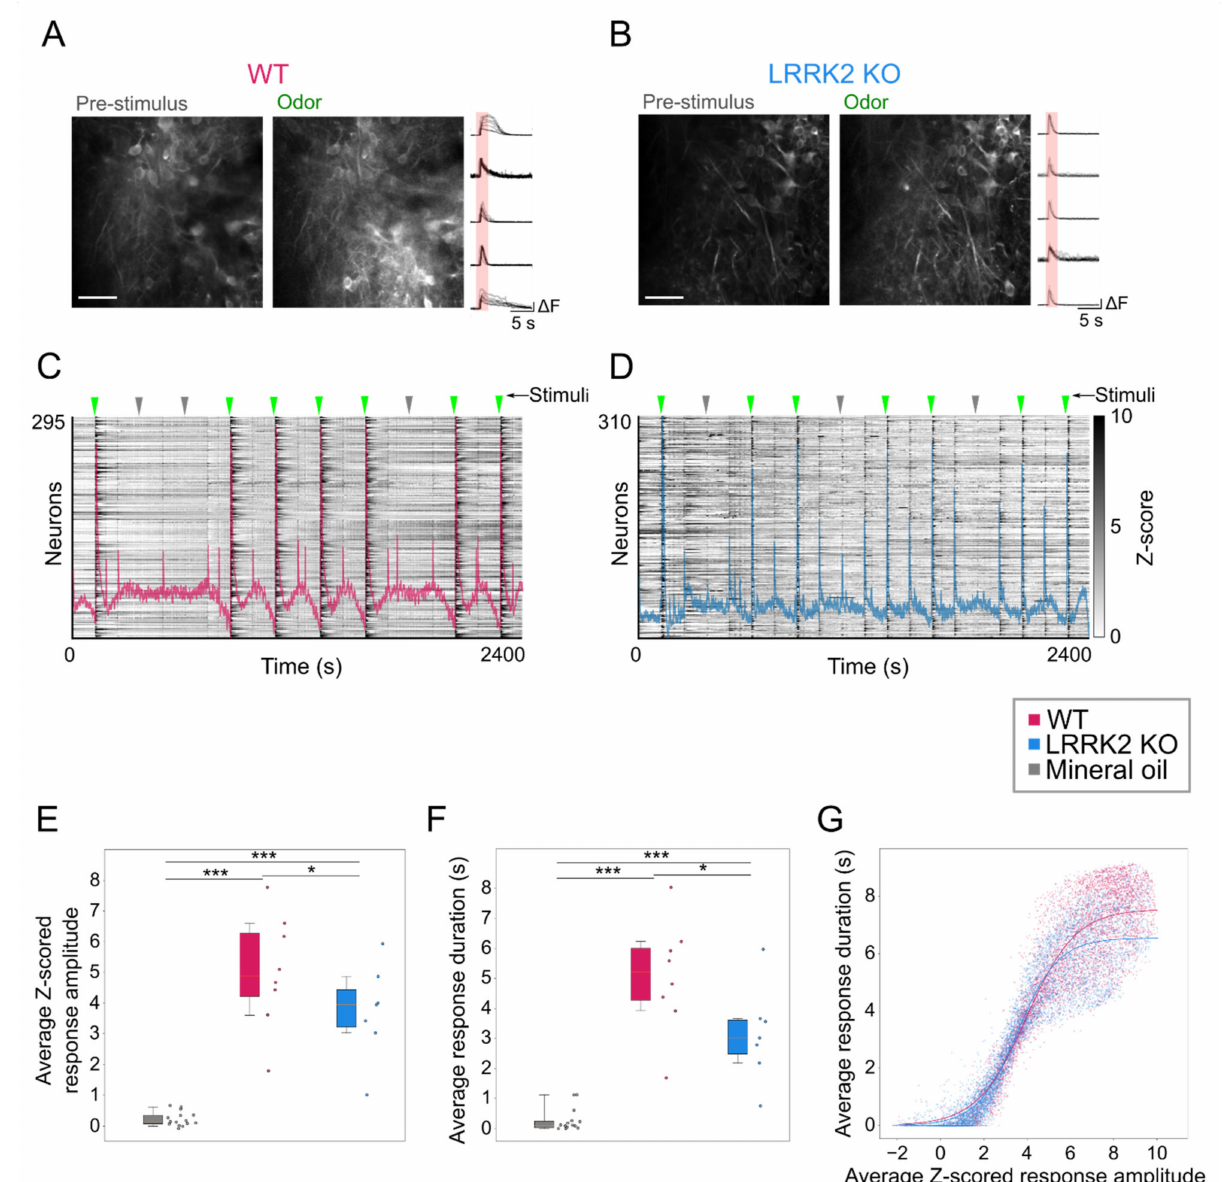
Figure 5. Abnormal mitral cells odor-evoked activity in the OB in LRRK2 KO mice. ( A , B ) Representative two-photon images in vivo of GCaMP6s-expressing mitral cells before (Pre-stimulus) and during odor stimulation (Odor) and odor-evoked Ca 2+ responses in different neurons during repeated odor stimulation (on the right) recorded in the OB of one WT (A) and one LRRK2 KO (B) mice. Scale bars = 100 µ m. ( C , D ) Raster plots of evoked Ca 2+ activity of the mitral cells in (A, B) respectively; odor presentation is indicated by green arrows, mineral oil presentation by grey arrows. The mean Ca 2+ trace related to the raster plot is superimposed. (E, F) Quantification of the amplitude ( E ) and duration ( F ) of Ca 2+ transients driven by odor stimulation in WT and LRRK2 KO mice and in response to mineral oil stimulation. Statistics are calculated on mice populations. Error bars = 5th to 95th percentile. ( G ) Scatter plot showing the correlation between mean amplitude and mean duration of odor-evoked Ca 2+ transients for each neuron in WT and LRRK2 KO mice. The continuous lines indicate the fitted sigmoid curve (WT asymptote at duration = 7.55 s; LRRK2 KO asymptote at duration = 6.54). Statistics are calculated on cell populations. * p < 0.05; *** p <